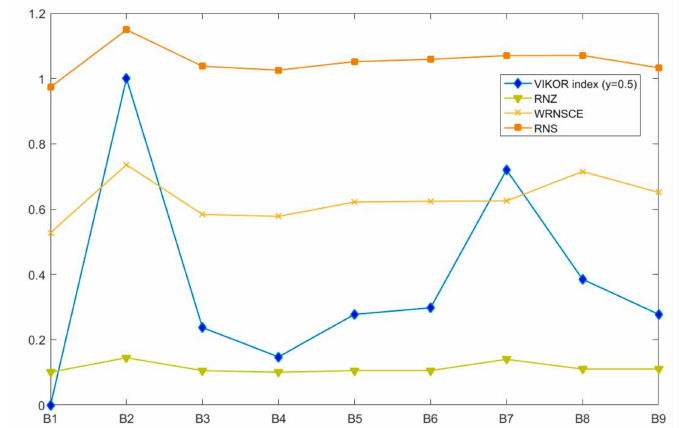
Figure 3. Relation between RNS, RNZ, WRNSCE and the VIKOR